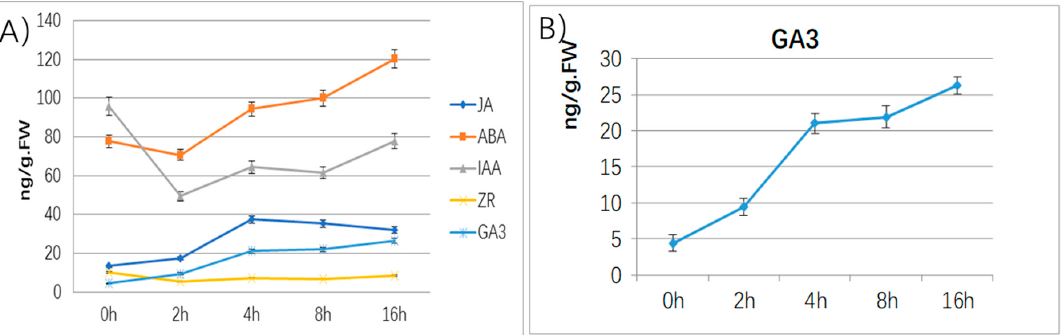
with the exogenous GA 3 treatment for 0h, 2h, 4h, 8h, 16h. 183